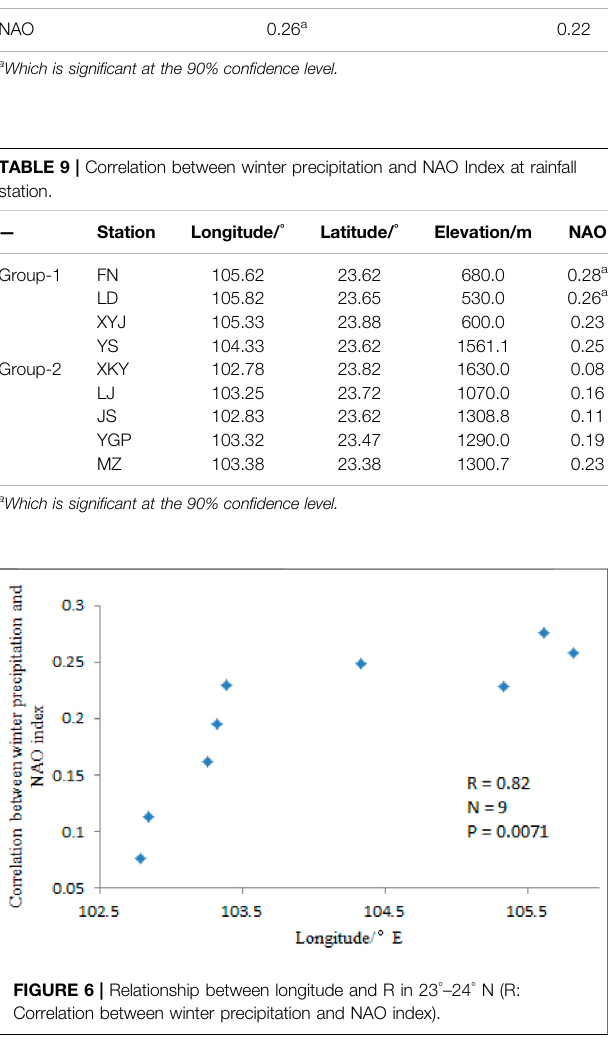
Frontiers in Environmental Science |